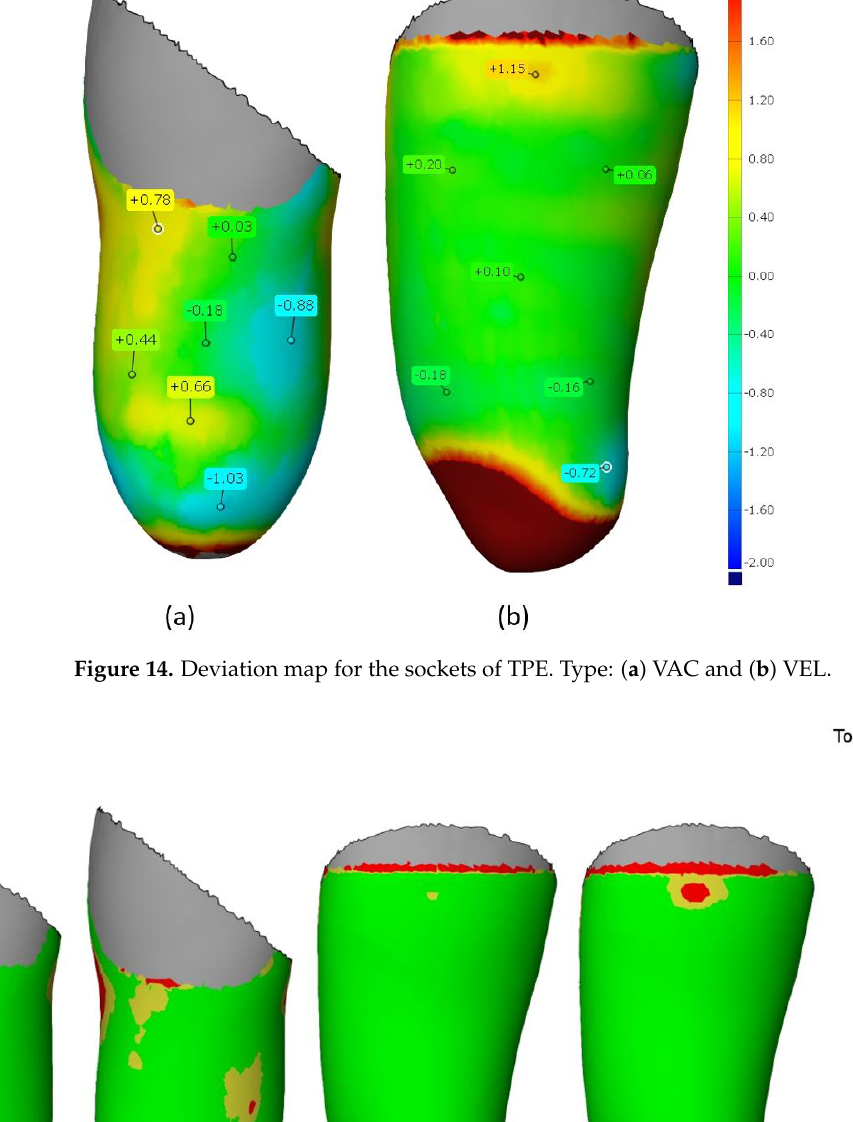
Figure 13. Deviation map for the sockets of PLA. Type: ( a ) VAC and ( b ) VEL.